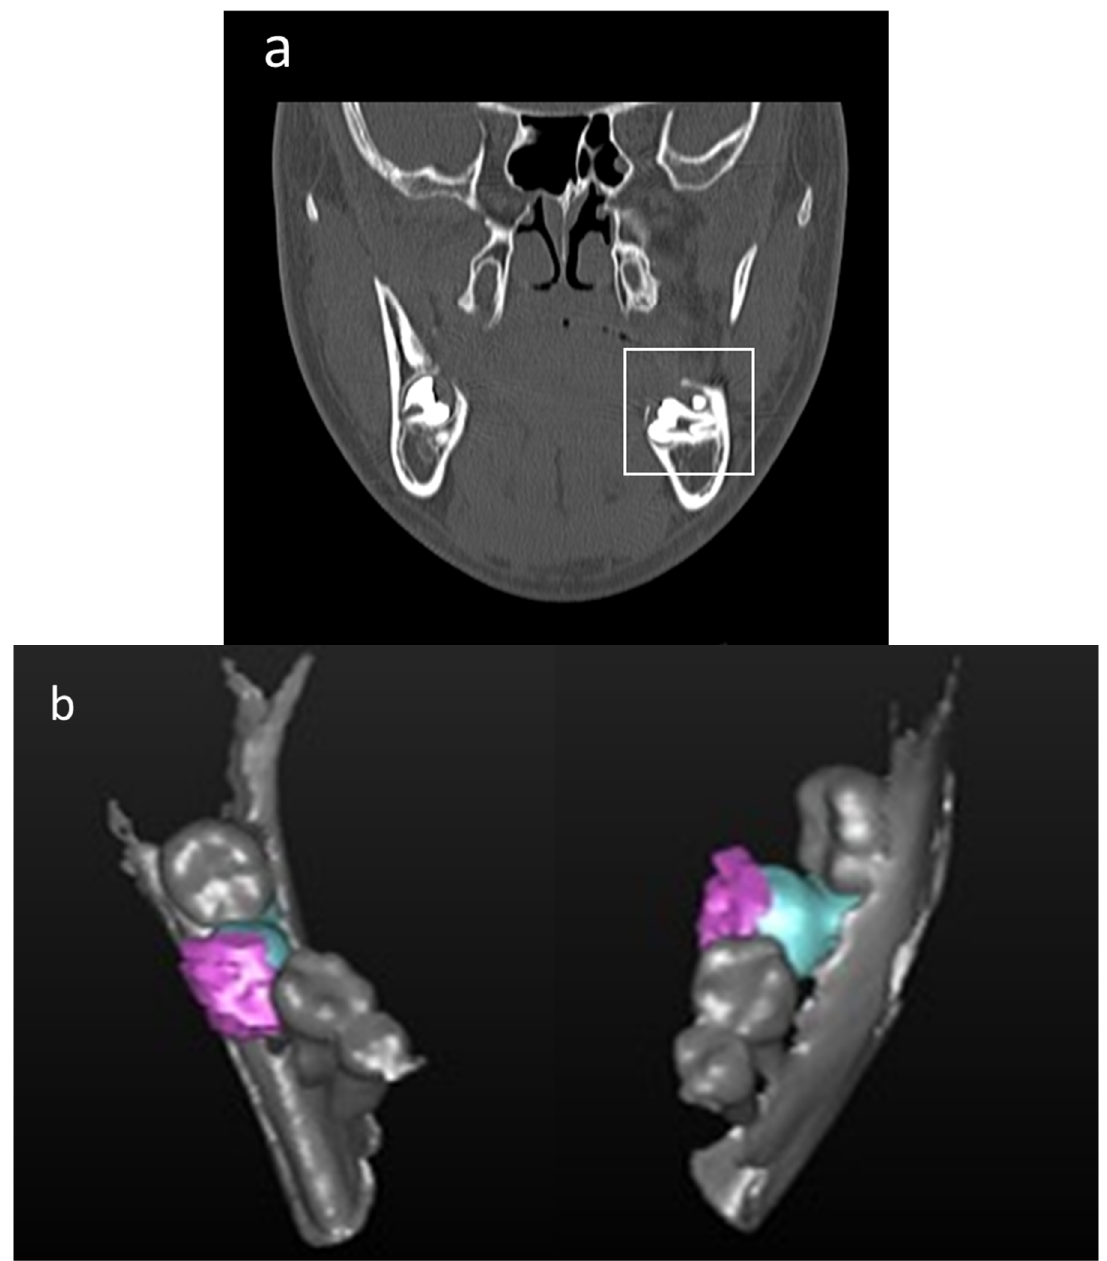
Figure 1. Radiographic findings of primordial odontogenic tumor. ( a ) The lesion presents in left side of the posterior mandible as a dentigerous cystlike, well-circumscribed radiolucency associated with an unerupted molar in computed tomography. ( b ) The lesion localizes around the crown of the second molar in 3D format (the lesion: purple; the second molar: blue).